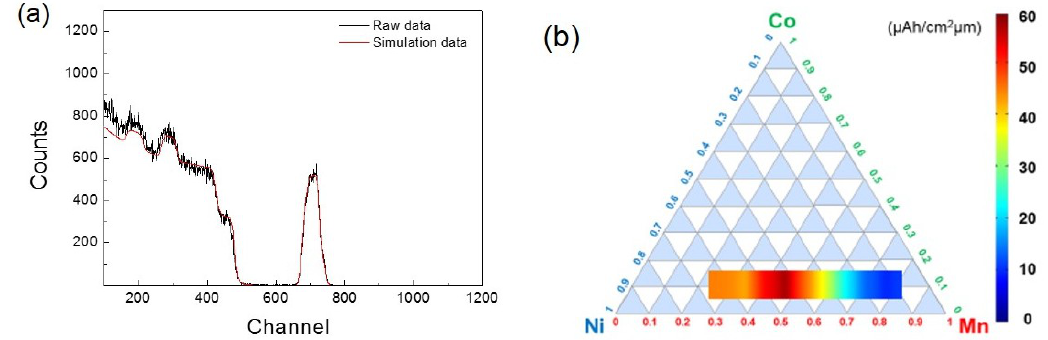
Figure 8. ( a ) RBS spectrum of thin film deposited at P4 and ( b ) diagram of compositions of P1–P9 samples.